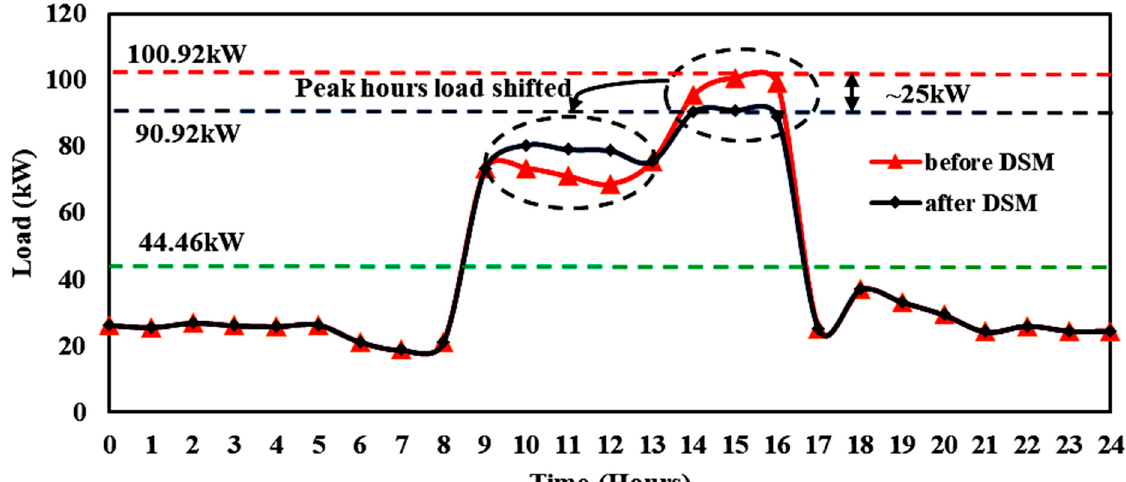
8 of 16 Figure 4. Peak clipping in daily load profile. Table 6. Peak clipped 25 kW load shifted from afternoon to morning. Time (Hours)